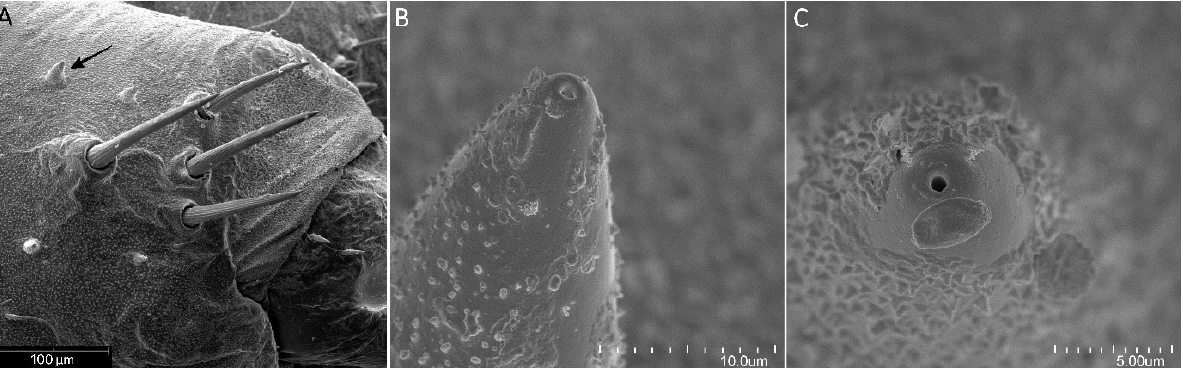
Figure 17. Psyttala horrida (Stål, 1865). ( A ) The antennal base with four trichoidea setae and small appendages [arrow]. ( B ) Magnification of the small appendage on the dorsal side of the head, thorax, and abdomen, lateral view and ( C ) dorsal view at the top with an apical pore.